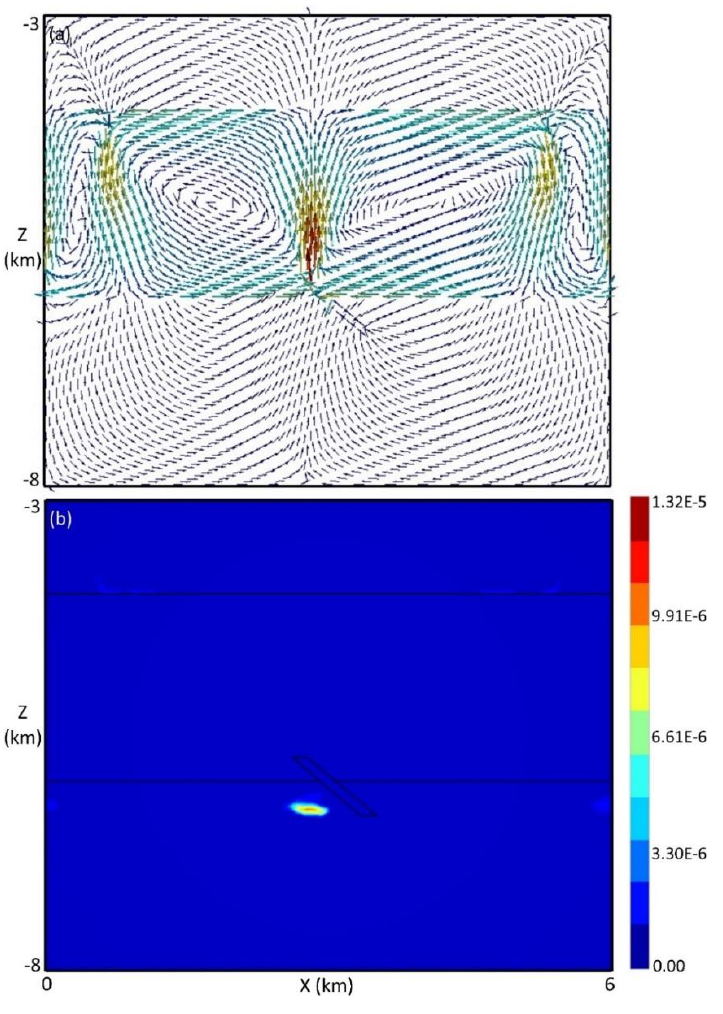
Figure 5. Numerical results at 300,000 years for Scenario 2: ( a ) the flow vectors, and ( b ) the precipi- tated uraninite and volume fraction.